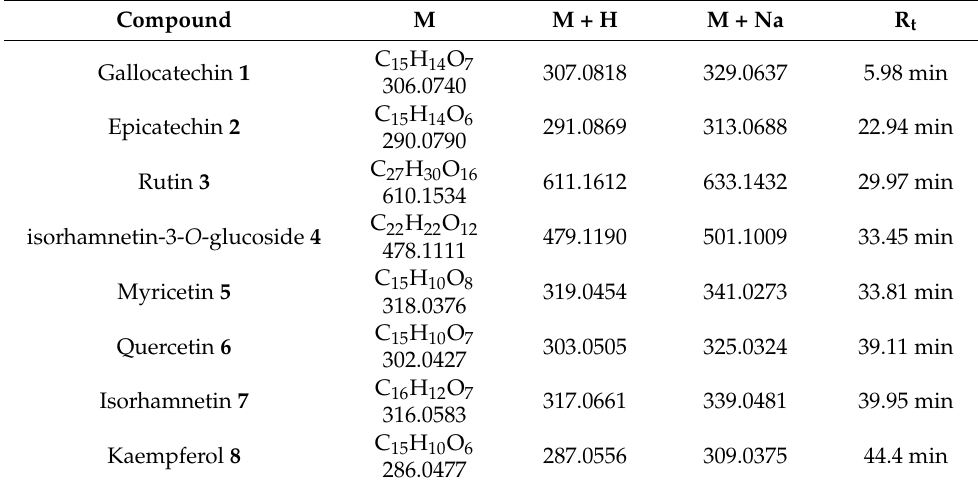
Figure 1. Structure of compounds gallocatechin 1, epicatechin 2 , rutin 3 , isorhamnetin-3- O -glucoside 4 , myricetin 5 , quercetin 6 , isorhamnetin 7 , and kaempferol 8 . Table 1. Retention times and exact masses of all standards compounds used.